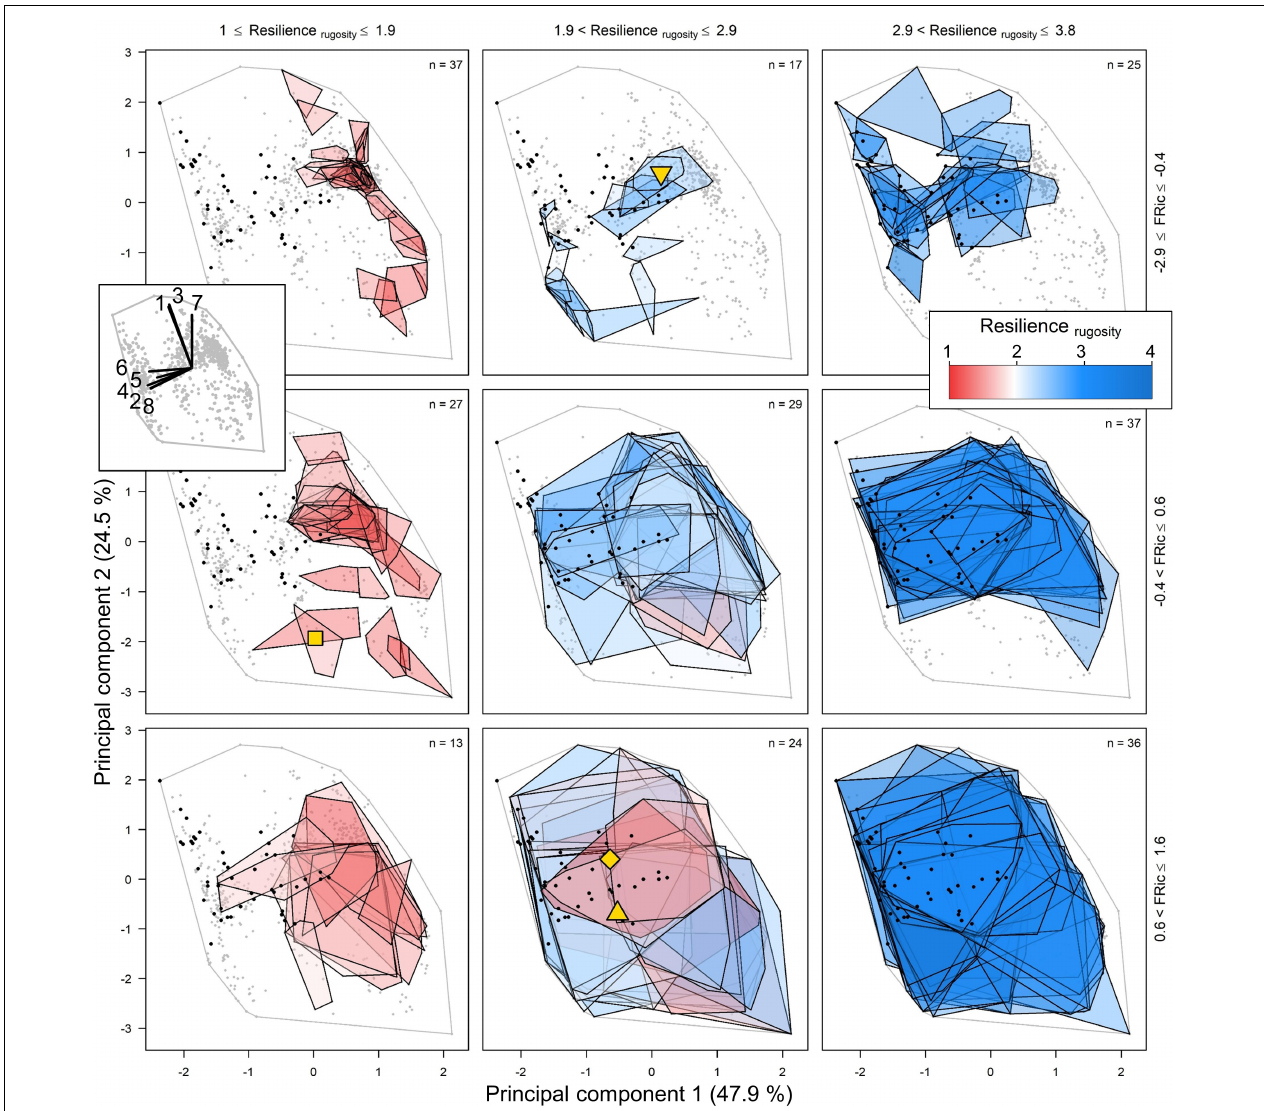
FIGURE 5 | Representation in the functional trait space of the 245 communities and their Resilience rugosity . Trait space is represented by principal component 1 and 2, which are the first two of four PCA axes from our trait analyses (cf. section “Independent Variables”; Supplementary Figure 4A ). Each polygon represents a unique community, and its area reflects its value of FRic . The red-blue color gradient reflects community resilience (rugosity). Gray and black dots show the location of all species ( n = 798) and those categorized as competitive ( n = 46) by Darling et al. (2012), respectively. See Figure 2 for details about the traits defining the functional trait space. The yellow symbols designate the centroids of the resilient communities presented in Figure 7 .